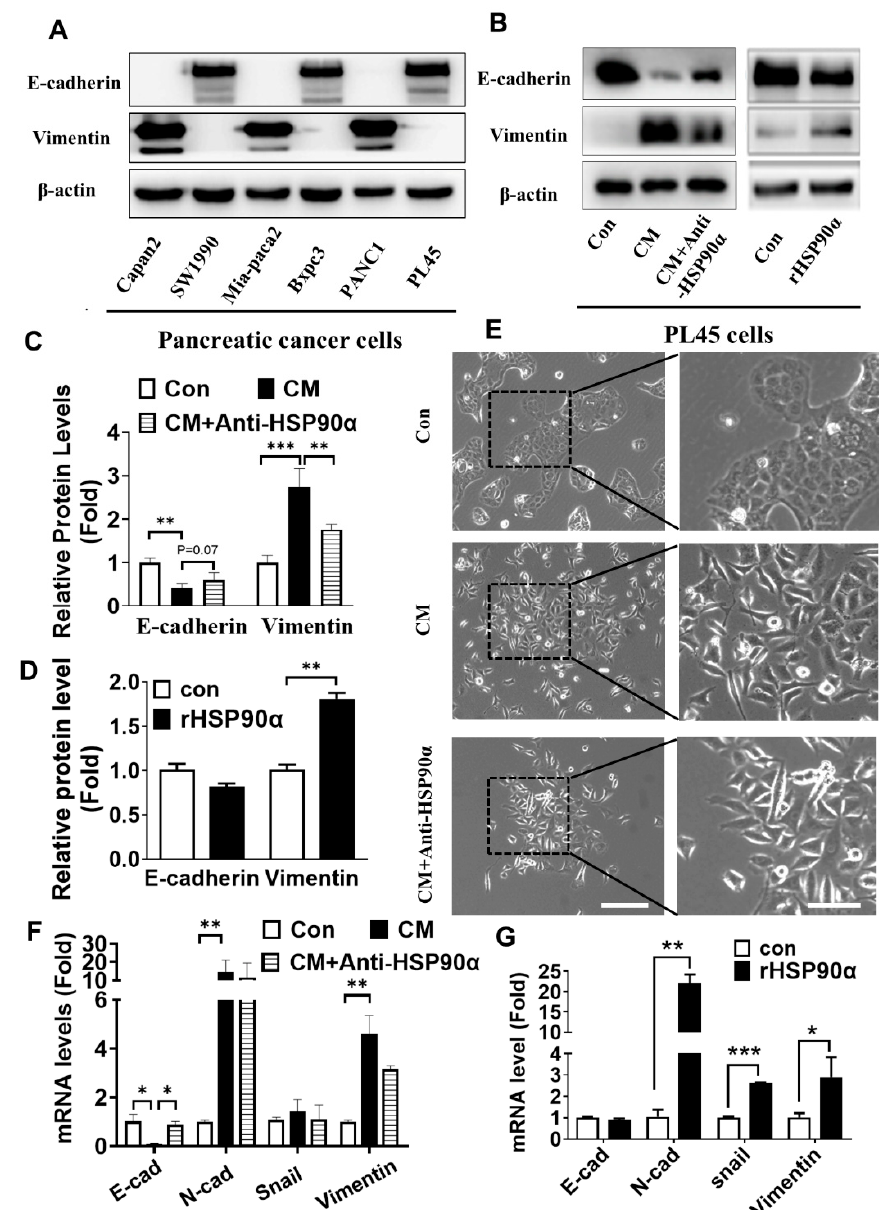
Figure 3. Secreted HSP90 α induces epithelial–mesenchymal transition (EMT) in PC cells. ( A ) The protein expressions of EMT marker genes (E-cadherin and vimentin) were examined from six human PC cell lines. ( B ) The expressions of E-cadherin and vimentin in CM-treated or rHSP90 α -treated PL45 cells, with or without the anti-HSP90 α antibody (5 µ g/mL), were detected by Western blot analysis. ( C , D ) The graphs show the quantitative evaluation of the relative protein levels. The results represent the averages of three independent experiments. ** p ≤ 0.01 and *** p ≤ 0.001. ( E ) The images of PL45 cells’ morphology after being stimulated by CM of Capan-2 or in the presence of the anti-HSP90 α antibody for 72 h. Scale bar, 5 µ m. ( F , G ) The relative mRNA levels of genes encoding E-cadherin, N ‐ cadherin, vimentin, and Snail in CM, CM plus the anti ‐ HSP90 α antibody, or rHSP90 α‐ treated PL45 cells were detected by qRT ‐ PCR. The data represent the mean ± SD of three independent measurements. * p ≤ 0.05, ** p ≤ 0.01 and *** p ≤ 0.001.